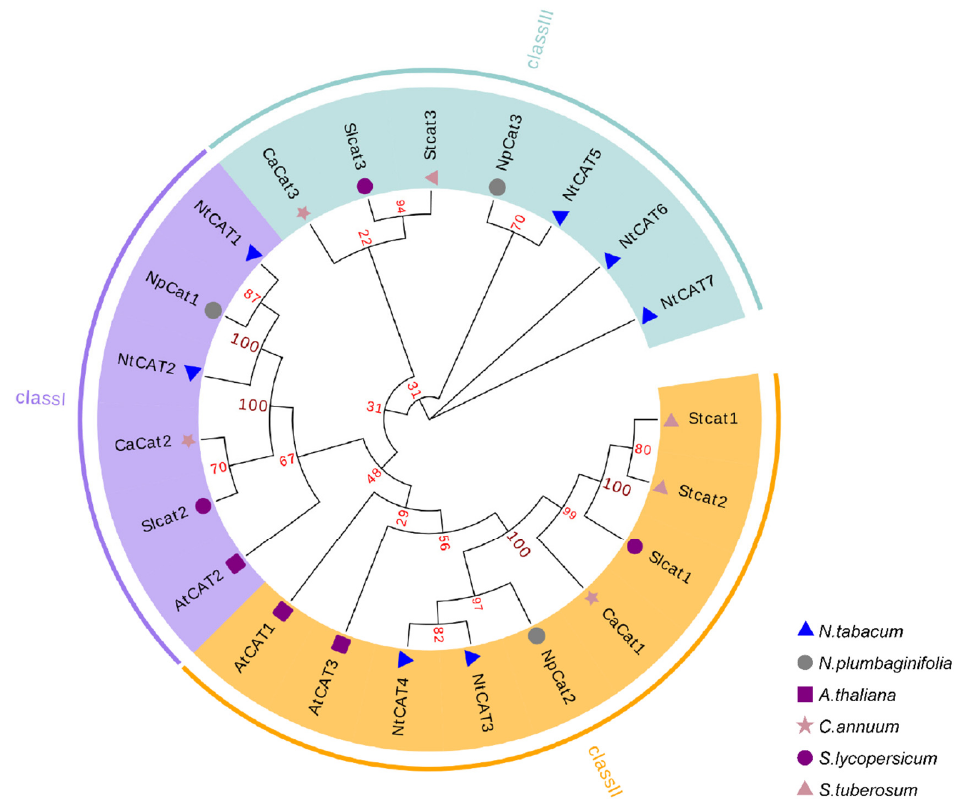
Figure 1. Phylogenetic relationships of CATs in six plants. GenBank accession numbers of CAT se ‐